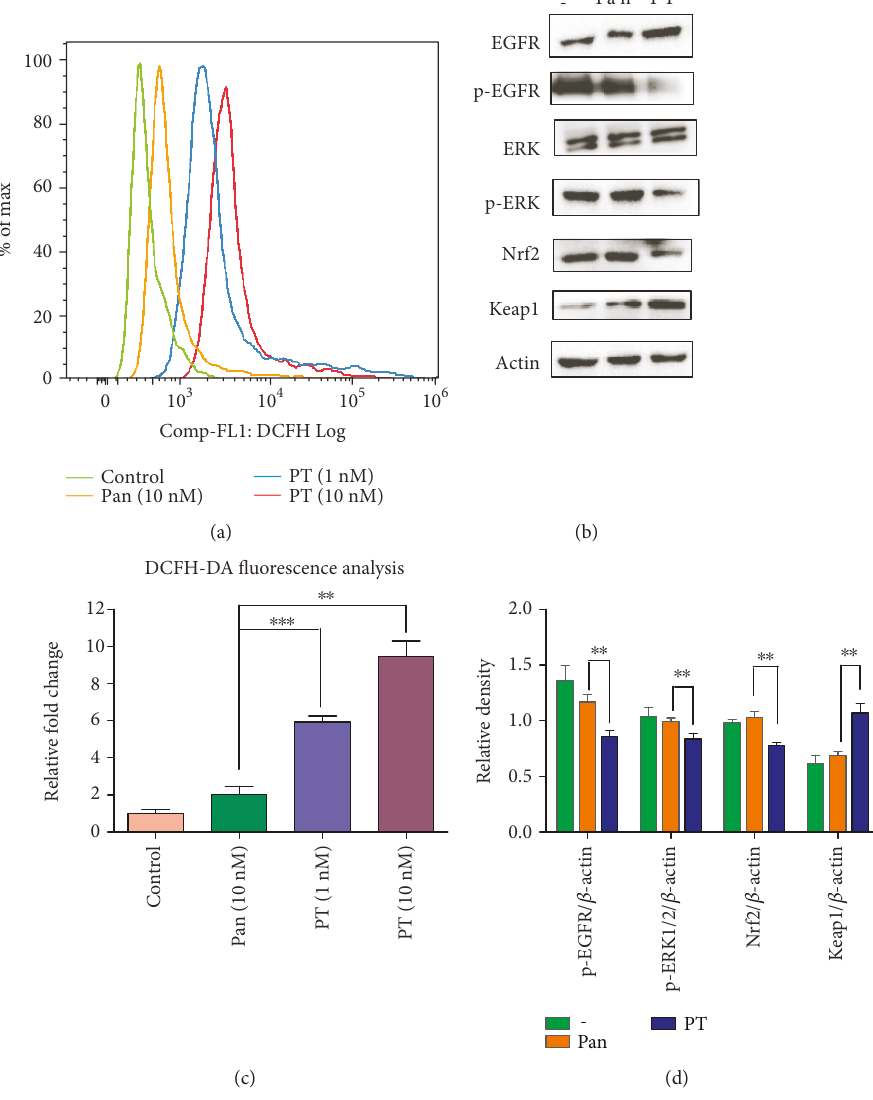
Figure 4: Treatment with PT resulted in ROS accumulation and caused repression of the Nrf2-Keap1 pathway. (a) KYSE-450 cells were treated with medium alone (control), Pan (10 nM), PT (1 nM), or PT (10 nM) for 10 hours, respectively, and fl ow cytometry was used to analyze the level of ROS accumulation in cells after DCFH-DA was added to stain the cells. (b) Key signaling molecules in response to treatments with Pan or PT treatment in KYSE-450 cells. Exponentially growing cells were treated with medium alone ( − ) or containing Pan (10 nM) or PT (10 nM) for 12 h before being analyzed. Then, EGFR, p-EGFR, ERK, p-ERK, Nrf2, and Keap1 were analyzed by western blot. (c) Bar graphic representations of the DCFH-DA fl uorescence intensity upon di ff erent treatments relative to control. ∗∗ p < 0 01 and ∗∗∗ p < 0 001 . (d) Quanti fi cation of western blot signal intensity analysis is expressed relative to the β -actin loading control by using the ImageJ software. Data show the mean ± SD (3 independent experiments). ∗∗ p < 0 01